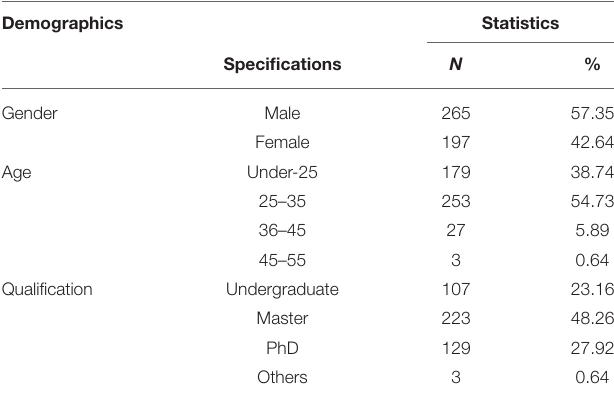
TABLE 1 | Characteristics of survey sampling ( n =